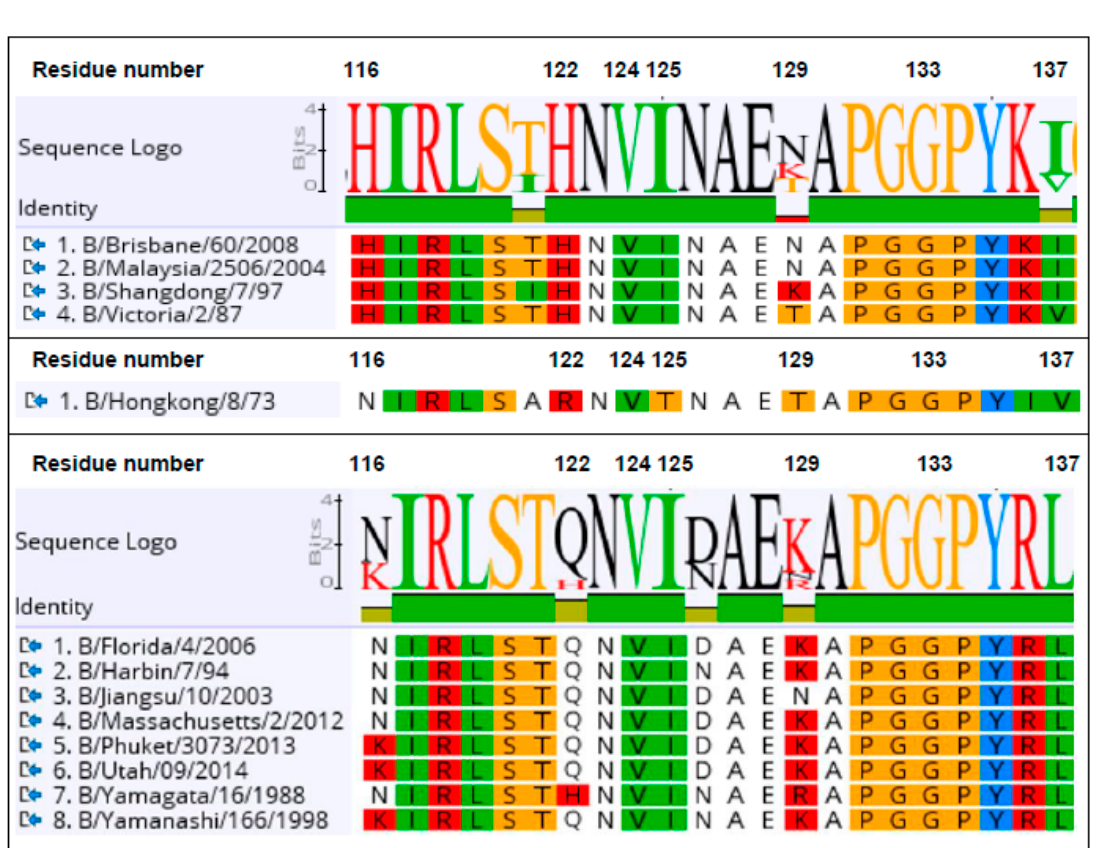
Figure 5. Sequence logo of antigen standards spanning predicted the epitope for lineage-specific, head-binding, single domain antibodies. Candidate residues, predicted to have a role in the binding epitope footprint of the Vic2a-6 are numbered, according to the B/HongKong/8/73 [29] within 116–137. Alignment of the B-Victoria (top) pre-lineage split strain (middle) and the B-Yamagata strains (bottom) are shown for the strains used to determine the sdAb-specificity profile (Table 2). Protein sequences used were translated from the DNA sequences: B/Brisbane/60/2008 (gb:ACN29380.1), B/Malaysia/2506/2004 (gb:ACR15732.1), B/Shangdong/9/97 (gb:AAM12546.1), B/Victoria/2/87 (gb:M58428.1) of the B-Victoria lineage; B/Yamagata/16/88 (gb:ABL77255.1), B/Yamanashi/166/98